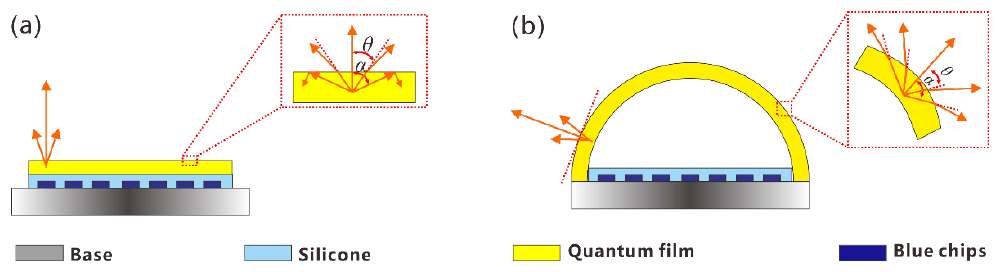
Figure 4. The optical model of planar-COB ( a ) and sphere-COB ( b ), respectively. The enlarged rectangle represents the unit luminescence mechanism.